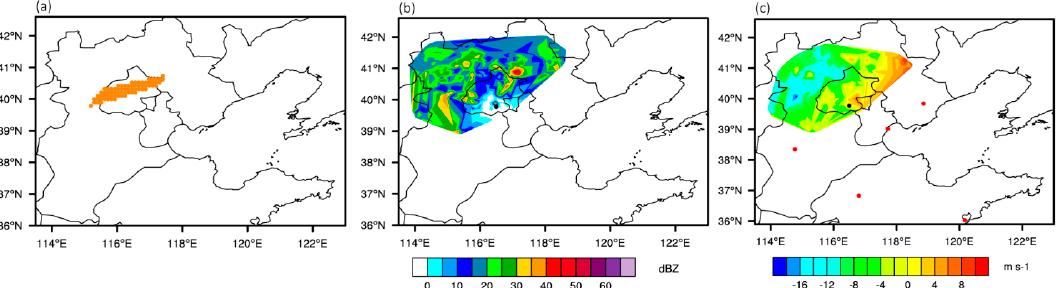
Figure 2. Assimilated observation data at 0300 UTC (Universal Time Coordinated) showing ( a ) location of observed total lightning from 0250–0300 UTC; ( b ) radar reflectivity at 1.5° elevation; and ( c ) radar radial velocity at 1.5° elevation. The Beijing Doppler radar location is marked with a black dot in ( b , c ). Five other Doppler radar locations are marked with red dots in ( c ).